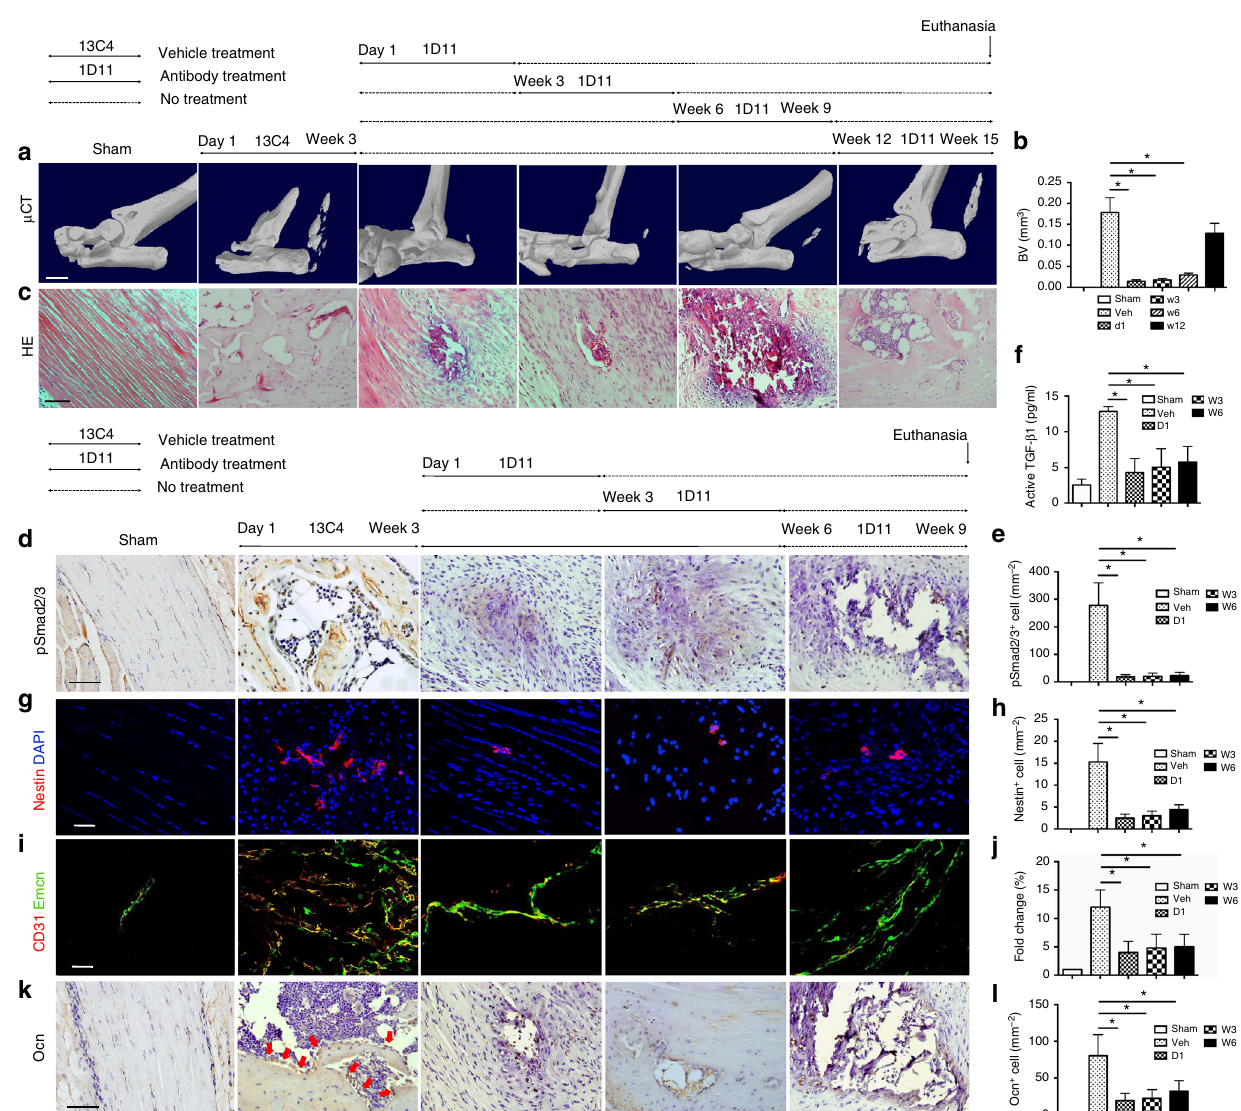
Fig. 4 Systemic injection of TGF- β neutralizing antibody reduces ectopic bone formation and type H vessel formation. a – c Mice were treated with 5 mg/kg body weight of the TGF- β neutralizing antibody 1D11 three times a week for 3 weeks from 1 day (D1), 3 weeks (W3), 6 weeks (W6), and 12 weeks (W12) after ATP and analyzed 15 weeks after ATP or sham surgery. a Micro CT images of the Achilles tendon (sagittal view) of mice and b quantitative analysis of bone volume of heterotopic bone determined by μ CT analysis. Scar bar, 2 mm. c H&E staining of ectopic bone of Achilles tendons. Scale bar, 50 μ m. d – l Mice were treated with 5 mg/kg body weight of 1D11 three times a week for 3 weeks from 1 day (D1), 3 weeks (W3), and 6 weeks (W6) after ATP and analyzed 9 weeks after ATP or sham surgery. d Immunostaining and e quanti fi cation of pSmad2/3 + cells in ectopic bone marrow. Scale bar, 50 μ m. f Active TGF- β in serum determined by ELISA. g Nestin + (red) cells in the ectopic bone marrow and h quanti fi cation. Scale bar, 50 μ m. Blue indicates DAPI staining of nuclei. i CD31 + (red) and Emcn + (green) cells in the ectopic bone marrow. j Quanti fi cation of the fold change of Type H vessels in 1D11-treated ATP mice normalized to that of Sham mice. Scale bar, 100 μ m. Yellow indicates type H vessels. k Immunostaining and l quanti fi cation of Ocn + cells of in ectopic bone marrow. Red arrow shows Ocn + cells. Scale bar, 50 μ m. All data are shown as the mean ± s.d. n = 8 per group. * p < 0.05 as determined by